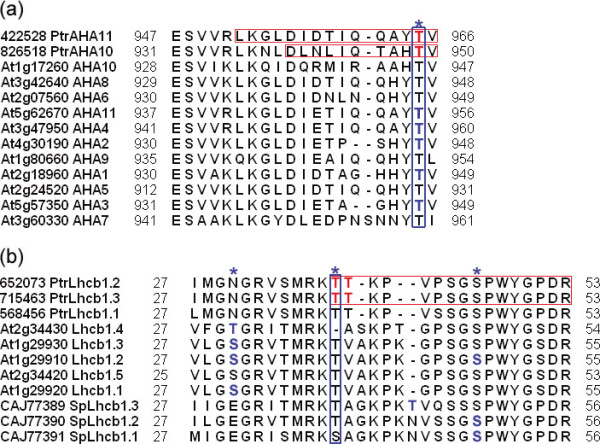
Conservation of phosphorylation sites between poplar proteins and homologs in other plants. Sequence alignments were conducted to determine conservation of phosphorylation sites among homologs. Gaps were introduced to ensure maximum identity. Fine red boxes represent phosphopeptides identified in this study. Phosphorylation sites identified in our study are shown in red bold font. Previously identified phosphorylation sites in Arabidopsis are indicated blue bold font. Well-conserved phosphorylation sites are shown within blue box in bold. Phosphorylation site is marked with an asterisk. (a) Phosphorylation sites conserved across plant plasma membrane H+-ATPases (AHA) orthologs. (b) Phosphorylation sites conserved across plant chlorophyll-a/b-binding protein 1 (Lhcb1) orthologs.